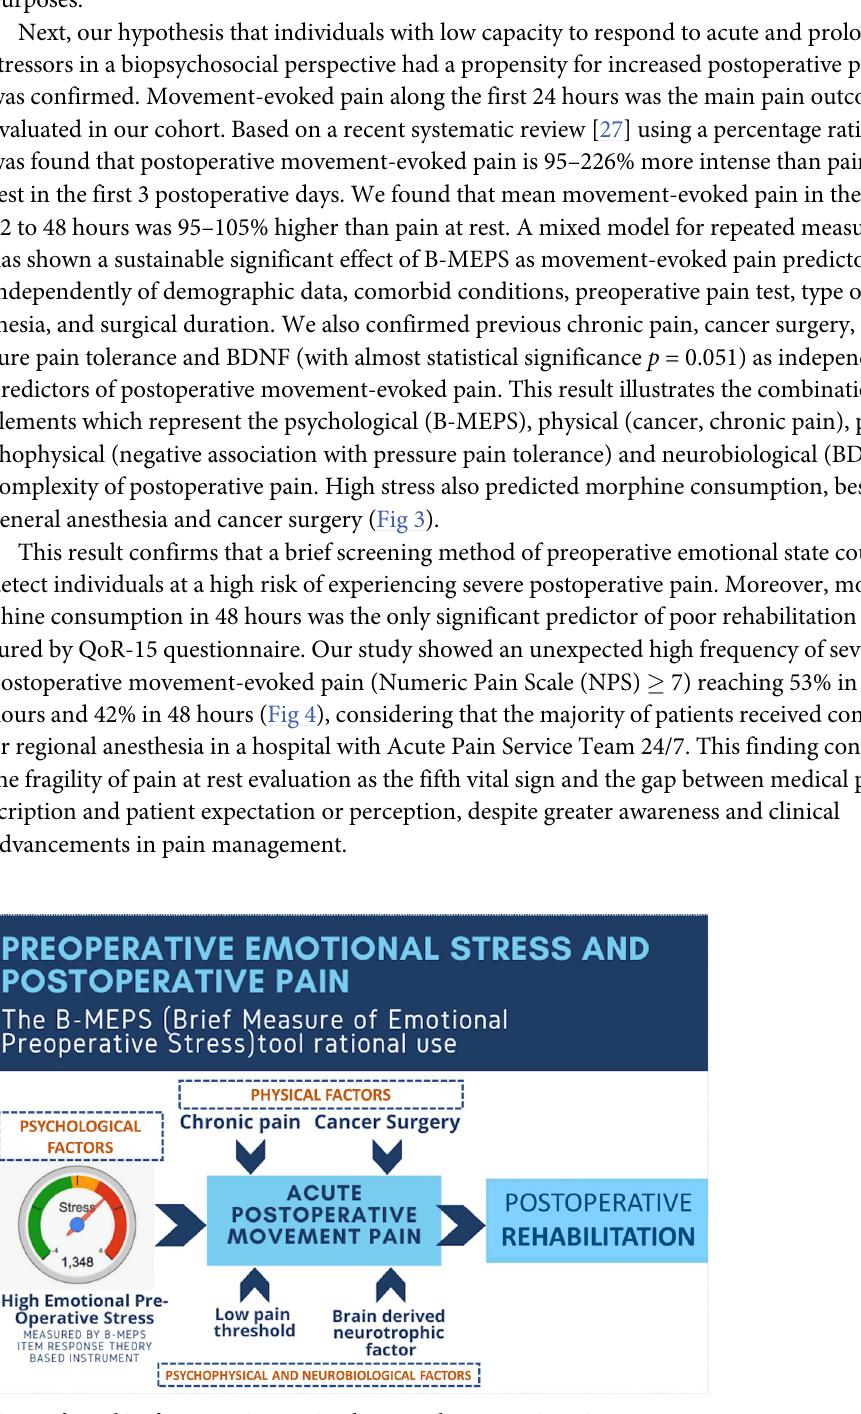
Fig 3. Infographic of preoperative emotional stress and postoperative